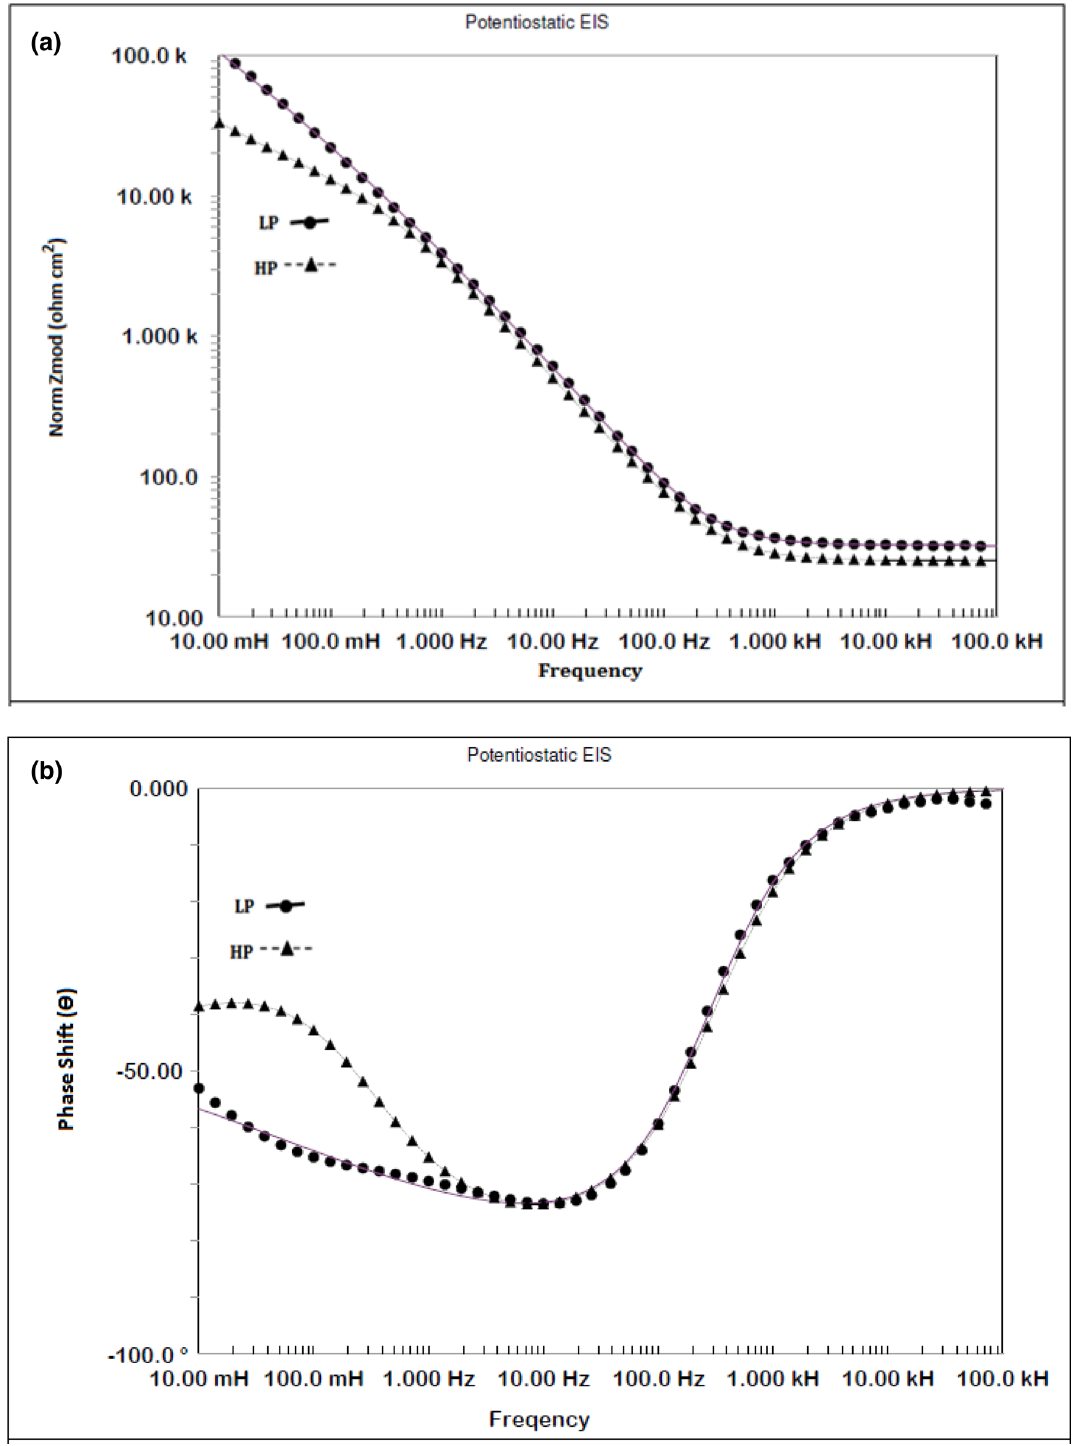
Figure 10. ( a ) Electrochemical impedance Bode plots for HP and LP steel bars after 24 h of exposure in chloride free SPSL. ( b ) Electrochemical frequency–phase shift Bode plots for HP and LP steel bars after 24 h of exposure in chloride free